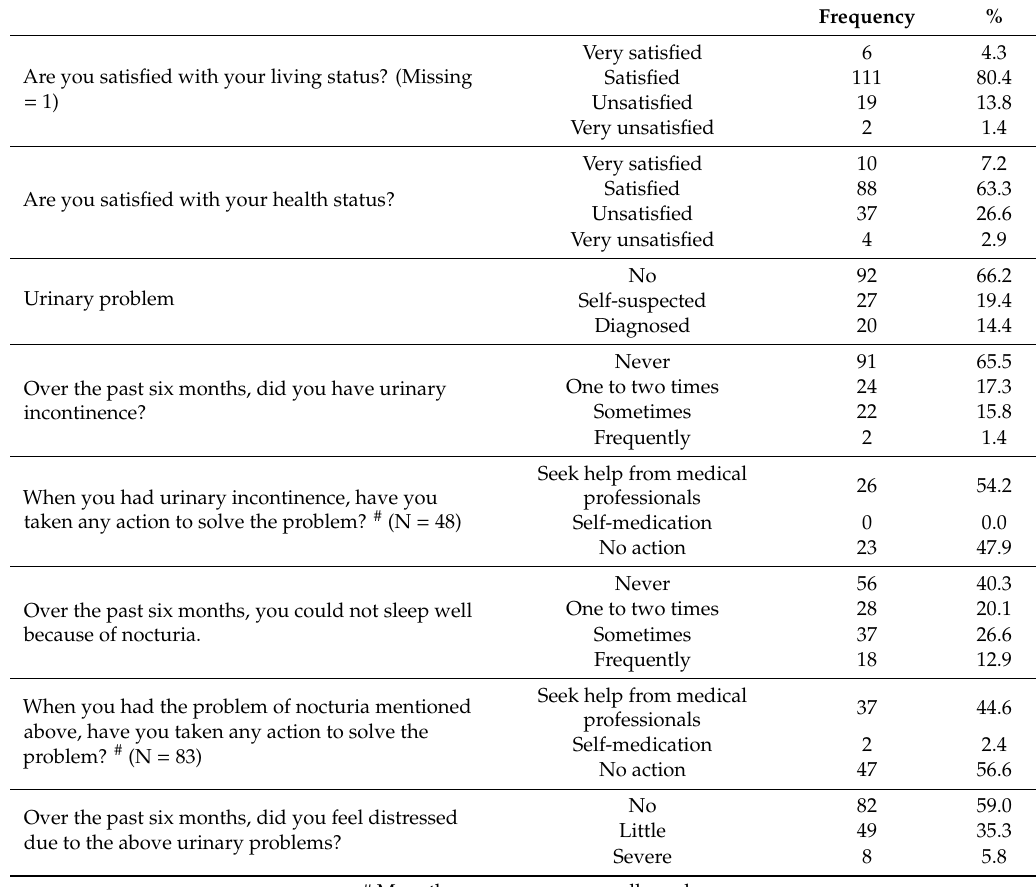
Table 2. Life satisfaction and urinary problems faced by the respondents (n =